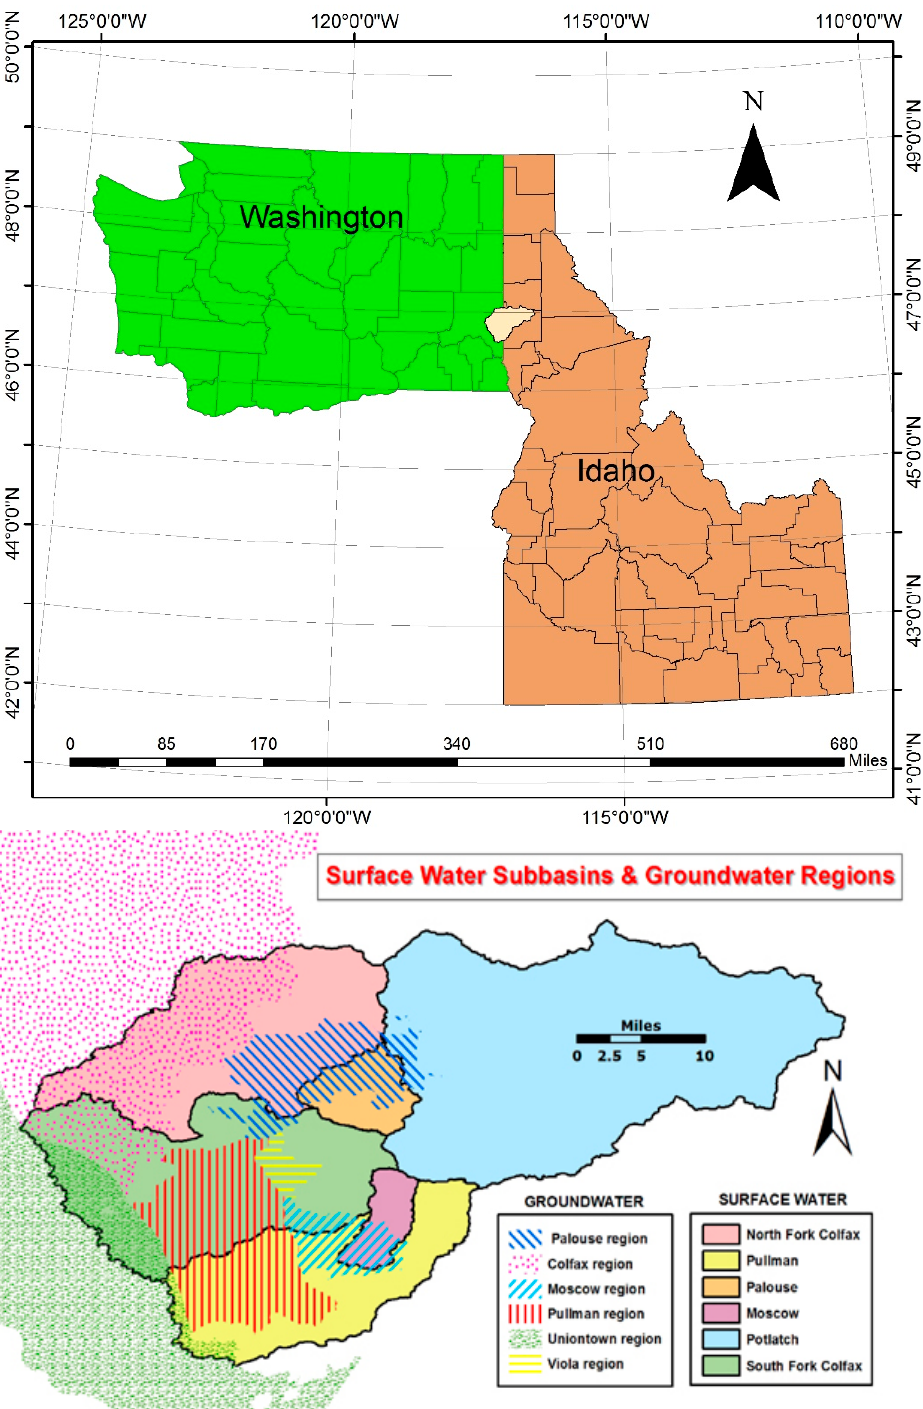
Figure 1. Location map of Palouse Basin watershed and surface water and groundwater regions.